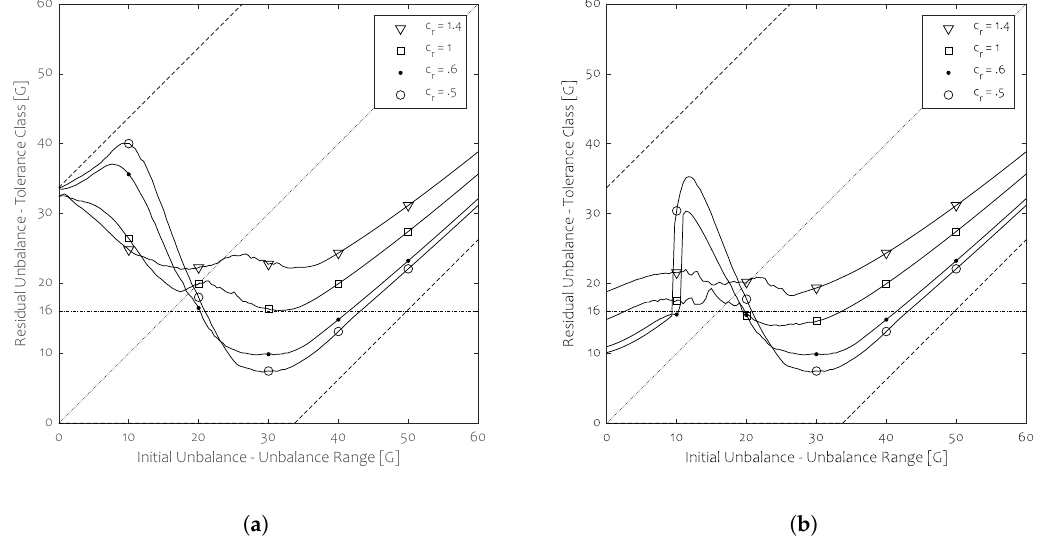
Figure 12. An increase of damping leads to a global deterioration of balancing capabilities for the STD and TSR technique. ( a ) STD, ( b )